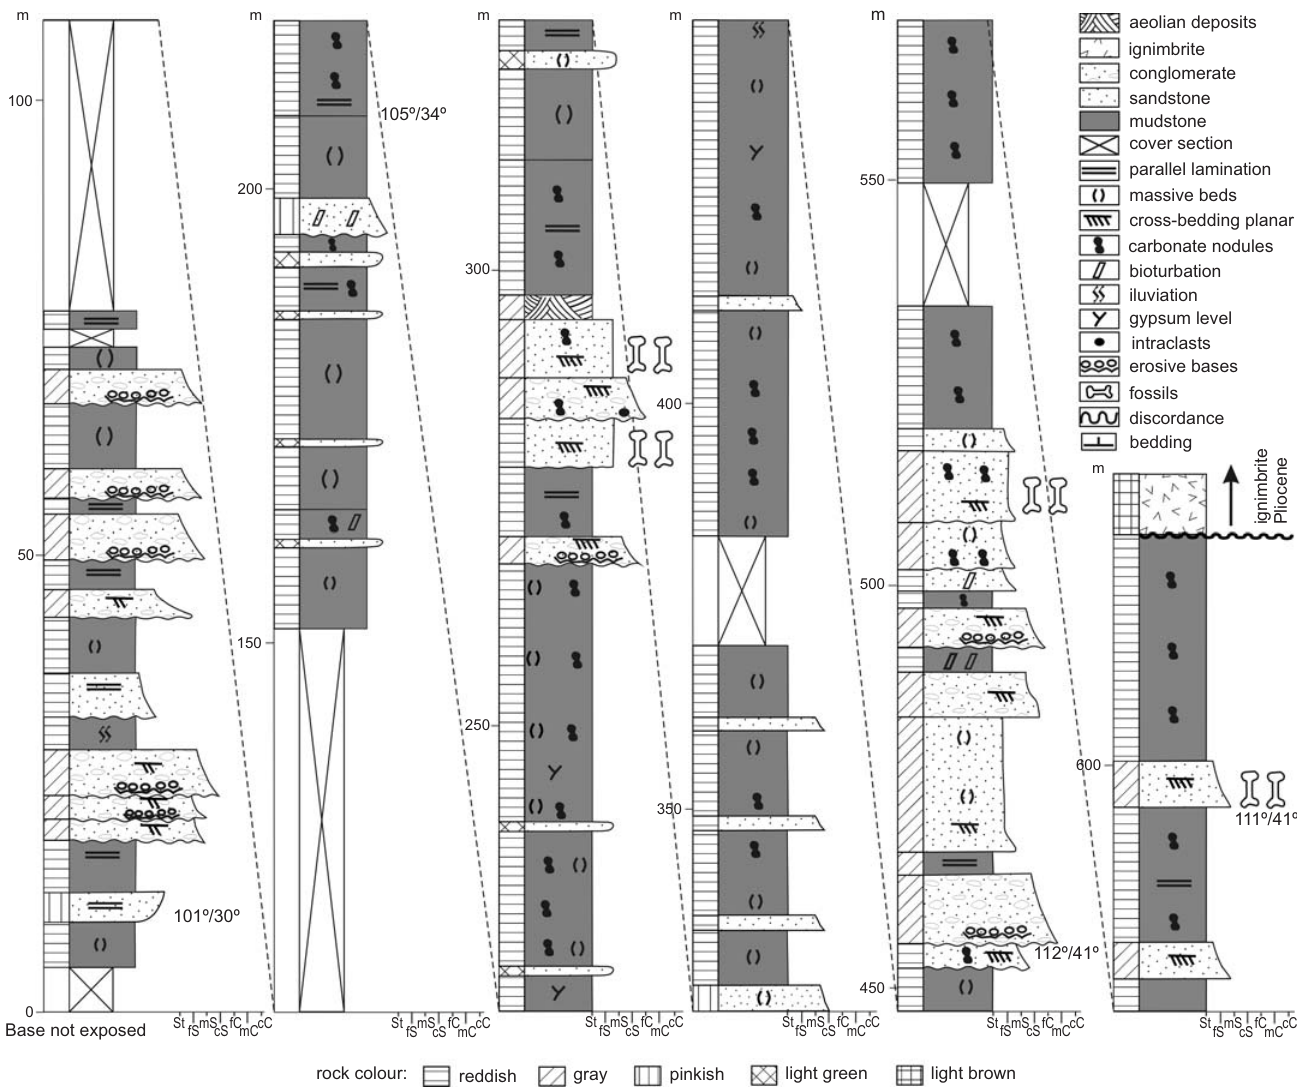
Fig. 3. Generalized lithostratigraphic profile of the Geste Formation exposed at Antofagasta de la Sierra, Catamarca, Argentina. Numbers indicate the bedding: strike/dip. Abbreviations: St, siltstone; S, sandstone; C, conglomerate; f, fine; m, medium; c,